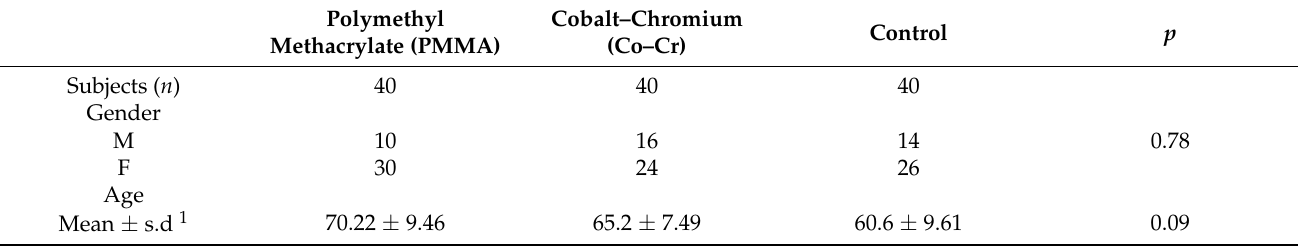
Table 1. Demographic data of the